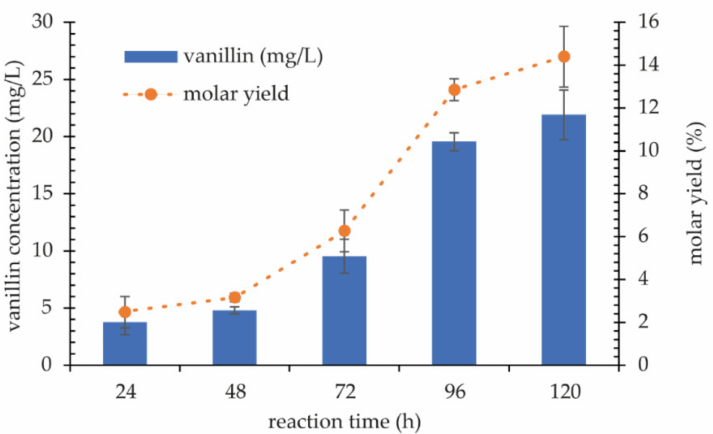
Figure 10. Transformation of the ferulic acid into vanillin by KbLcc1 laccase (0.1 U) with 1 mM ABTS as a redox mediator at 20 ◦ C and pH 3.5 (optimal for ABTS